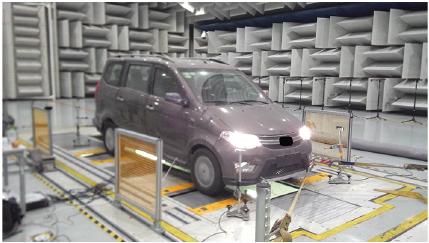
Figure 6: Minivan internal noise TPA test.